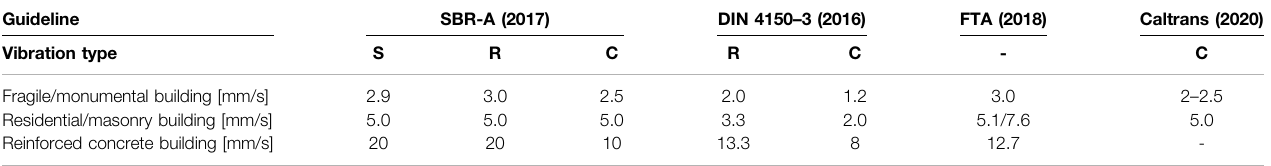
TABLE 1 | Overview of vibration thresholds in terms of peak vibration velocity (in mm/s) from international guidelines and standards for the assessment of vibration-induced cosmetic damage to buildings.